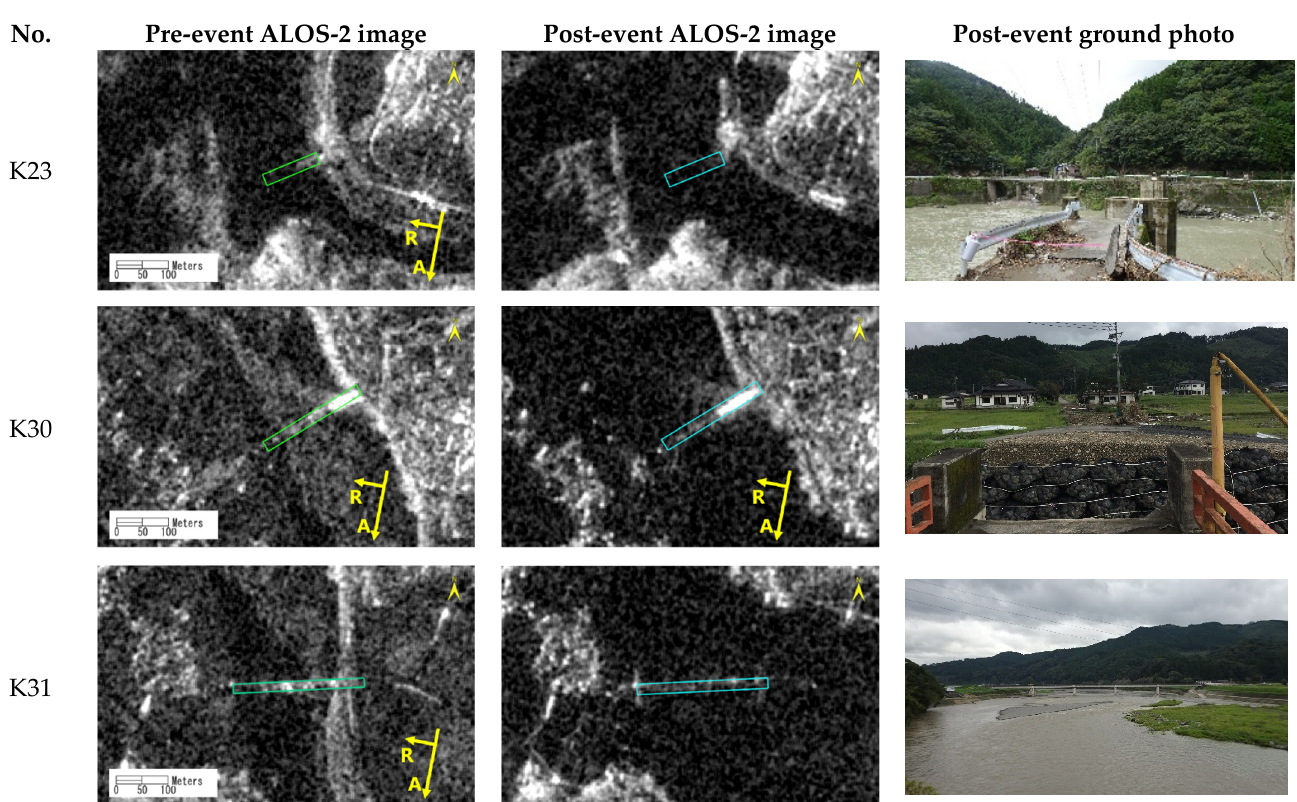
Figure 7. Two collapsed bridges, K23 and K30, that could not be identified by the RF model using five features for data set 2, and one surviving bridge, K31, which was misclassified as collapsed.